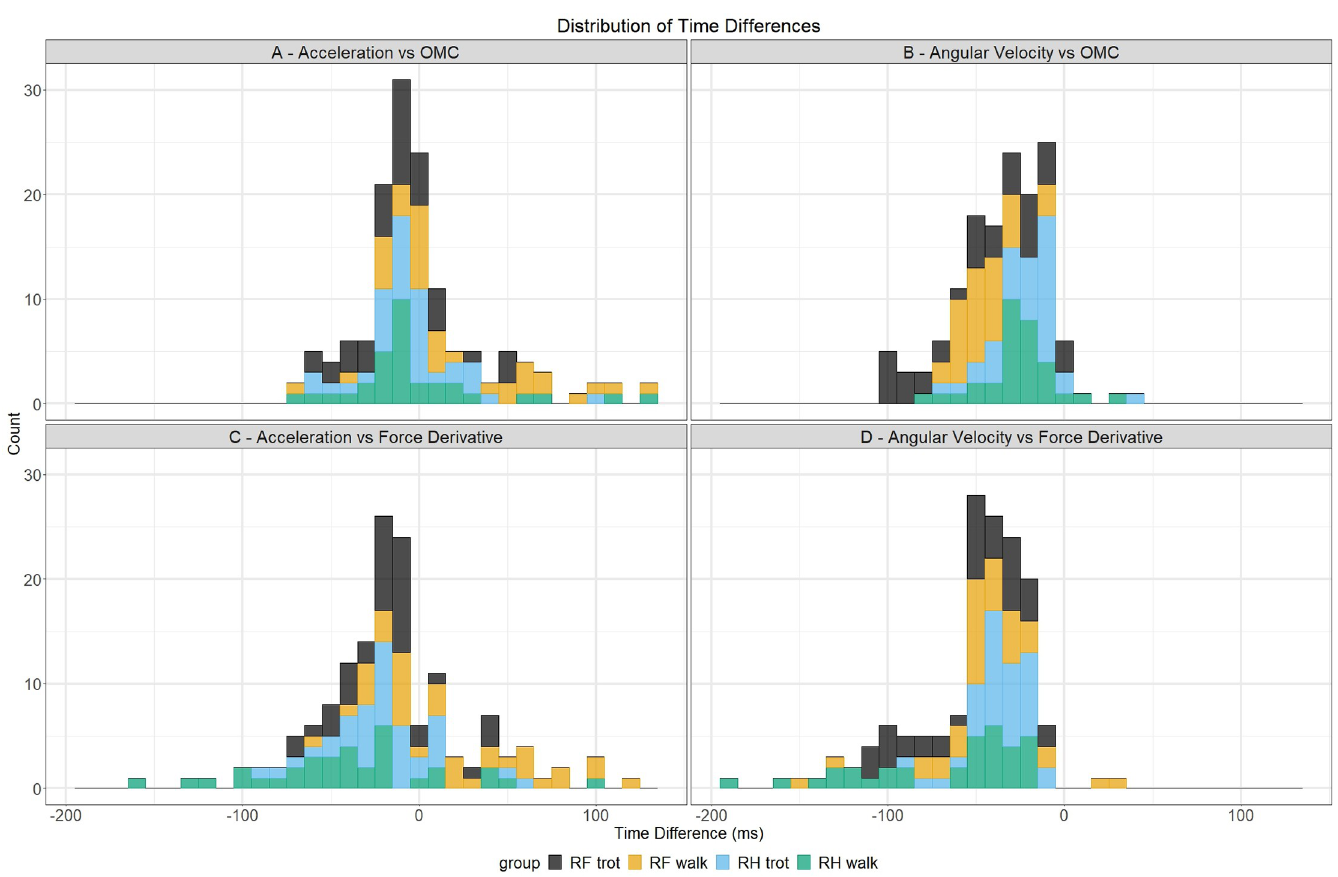
Fig 2. Distributions of time differences between both algorithms and reference methods for the break-over phase onset detection. Time differences with the OMC system are depicted in the upper row and time differences with the force derivative are depicted in the bottom row. The different hoof/gait combinations are depicted with their own